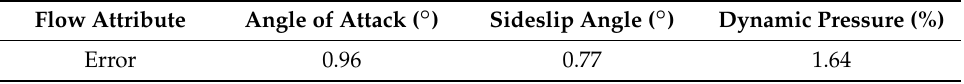
Table 4. Calibration errors of leading-edge